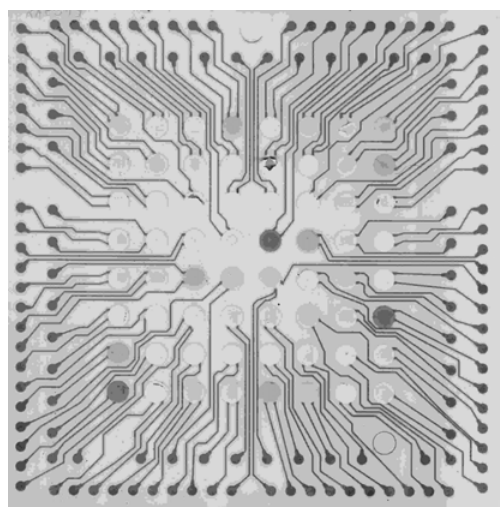
Figure 9. Image of the In/W mixed oxide